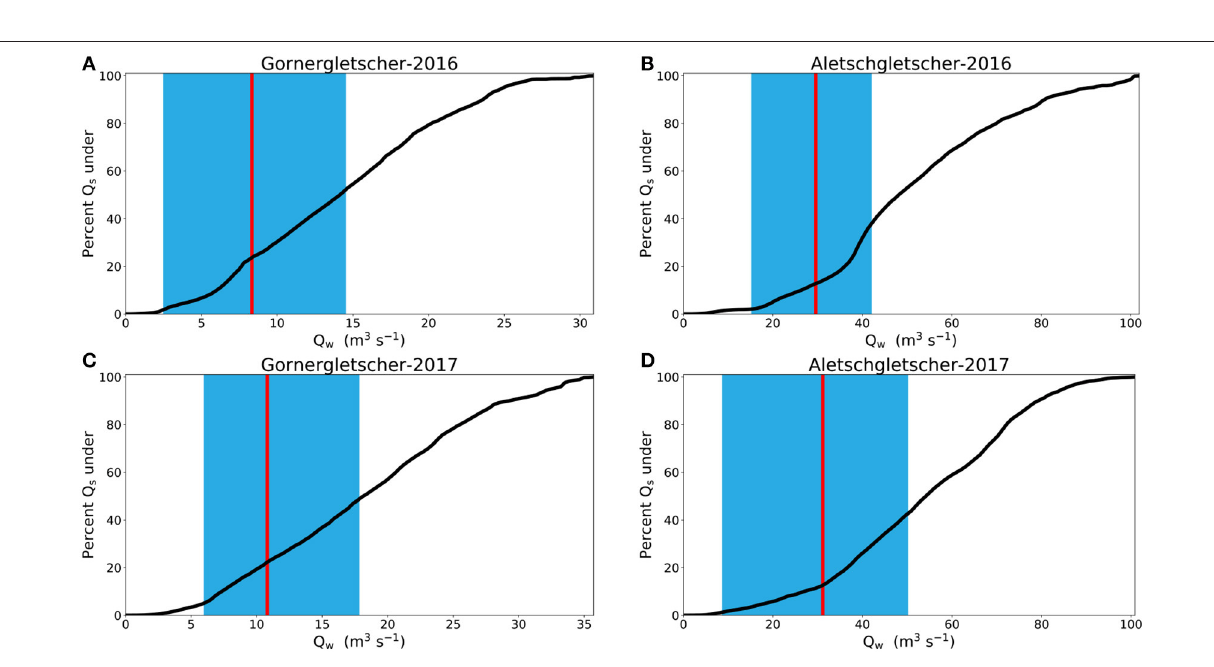
Frontiers in Earth Science |